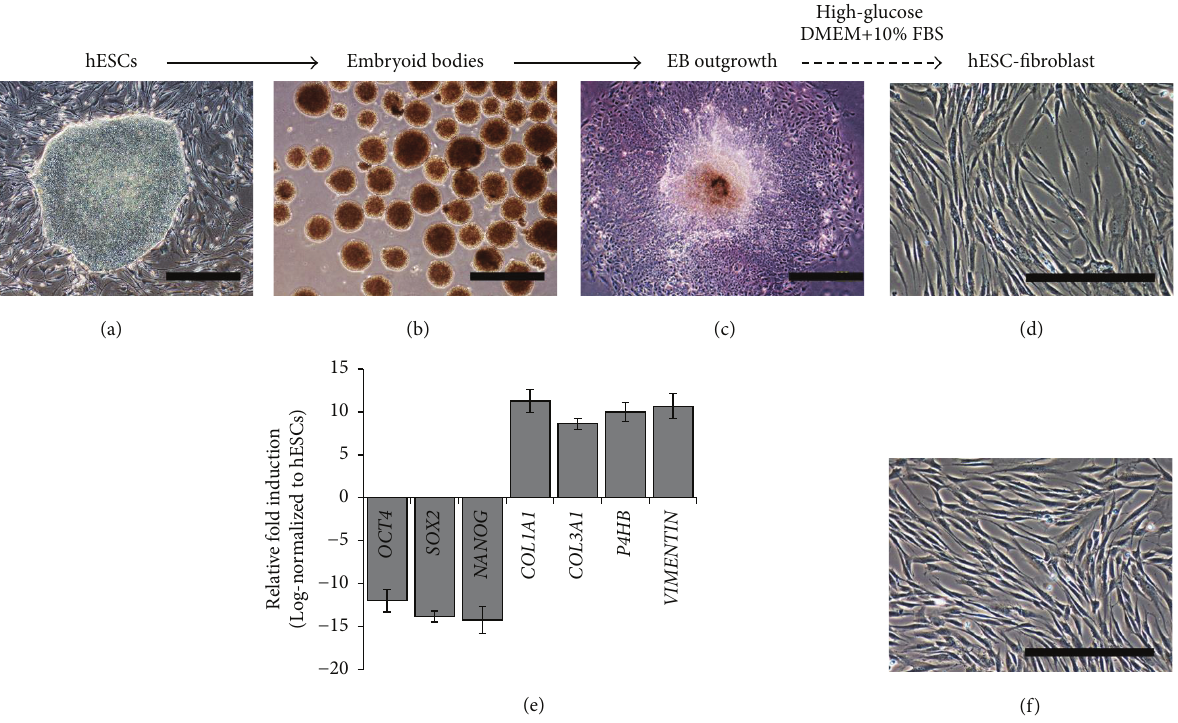
Figure 1: Differentiation of hESCs to hESC-Fib. (a–d) The photomicrographs demonstrate the differentiation of hESCs to embryoid bodies, embryoid body outgrowth, and hESC-Fib under high-glucose differentiation conditions. (e) Characterization of hESC-Fib by real-time RT-PCR for pluripotency (OCT4, SOX2, and NANOG) and fibroblast-related transcripts ( COL1A1 , COL3A1 , P4H 𝛽 , and VIMENTIN ). (f) Photomicrograph shows the spindle-shaped hPLFs. Scale bar: 500 𝜇